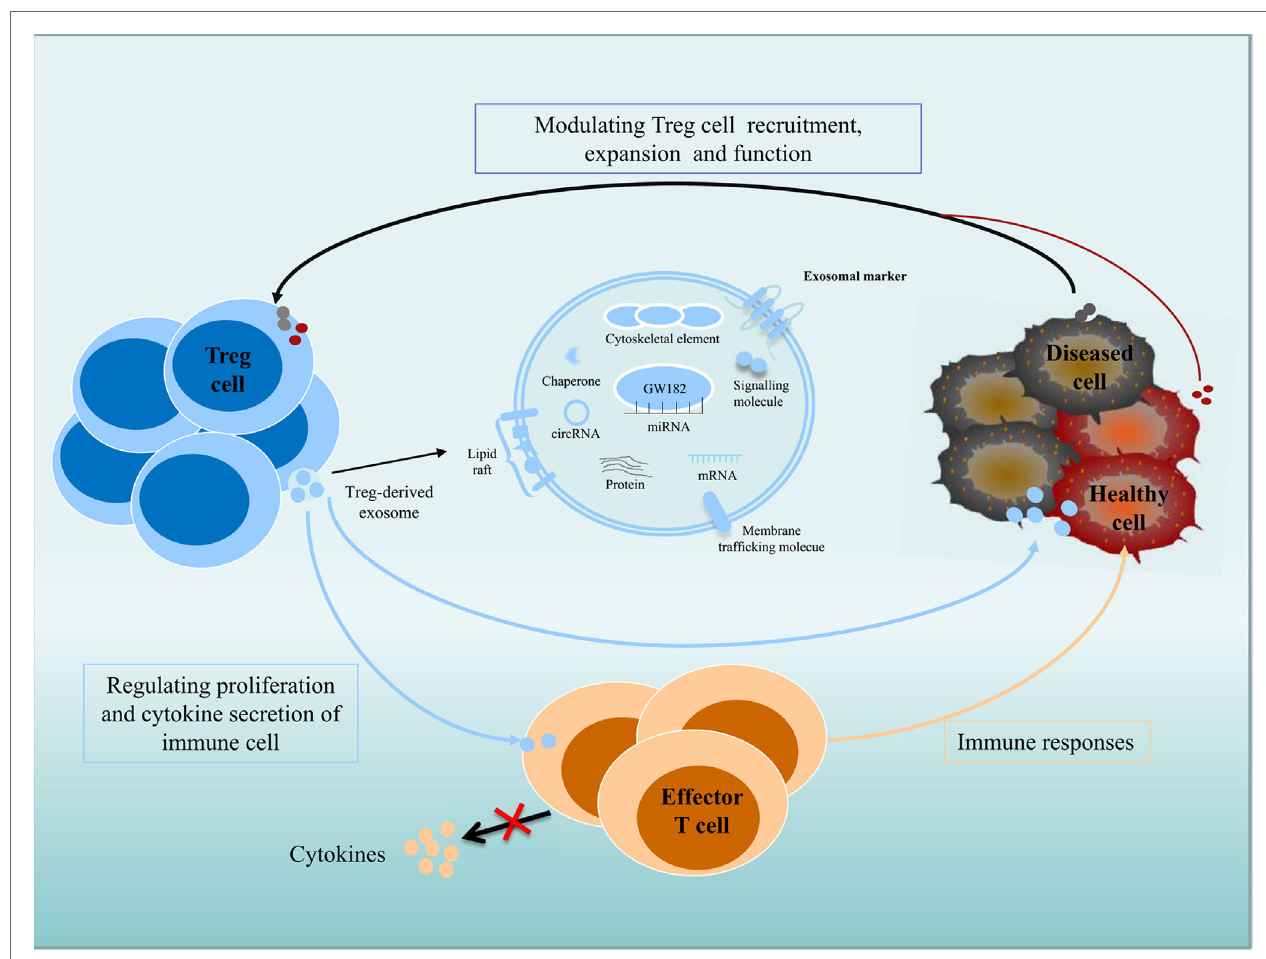
FiGURe 1 | Role of exosomes in intercellular communication between Treg cells and recipient or donor cells . Exosomes transfer their contents, including proteins, lipids, and RNAs, between cells. Immune and non-immune cell-derived exosomes have important roles in the regulation of immunity. Exosomes contribute significantly to the function of Treg cells, and Treg cell-derived exosomes can be delivered to immune cells and diseased or healthy tissue cells; regulate the proliferation and cytokine secretion of effector T cells; and modulate the immune response. Diseased cells, including tumor cells, can modulate Treg cell recruitment, expansion, and function via an exosome-based